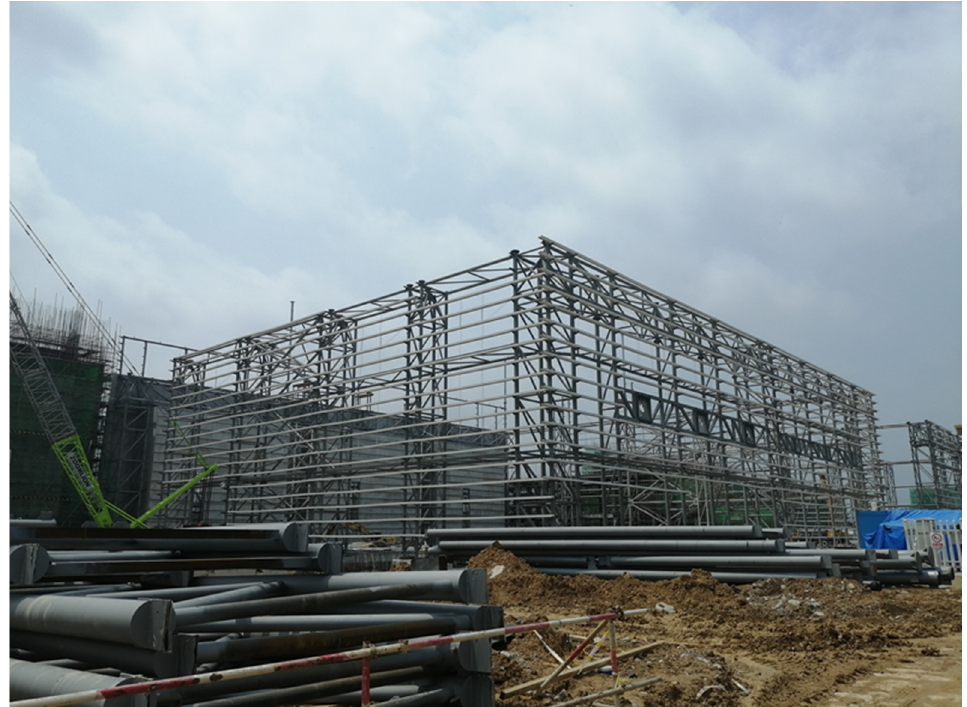
Figure 1. Converter station steel structure site.